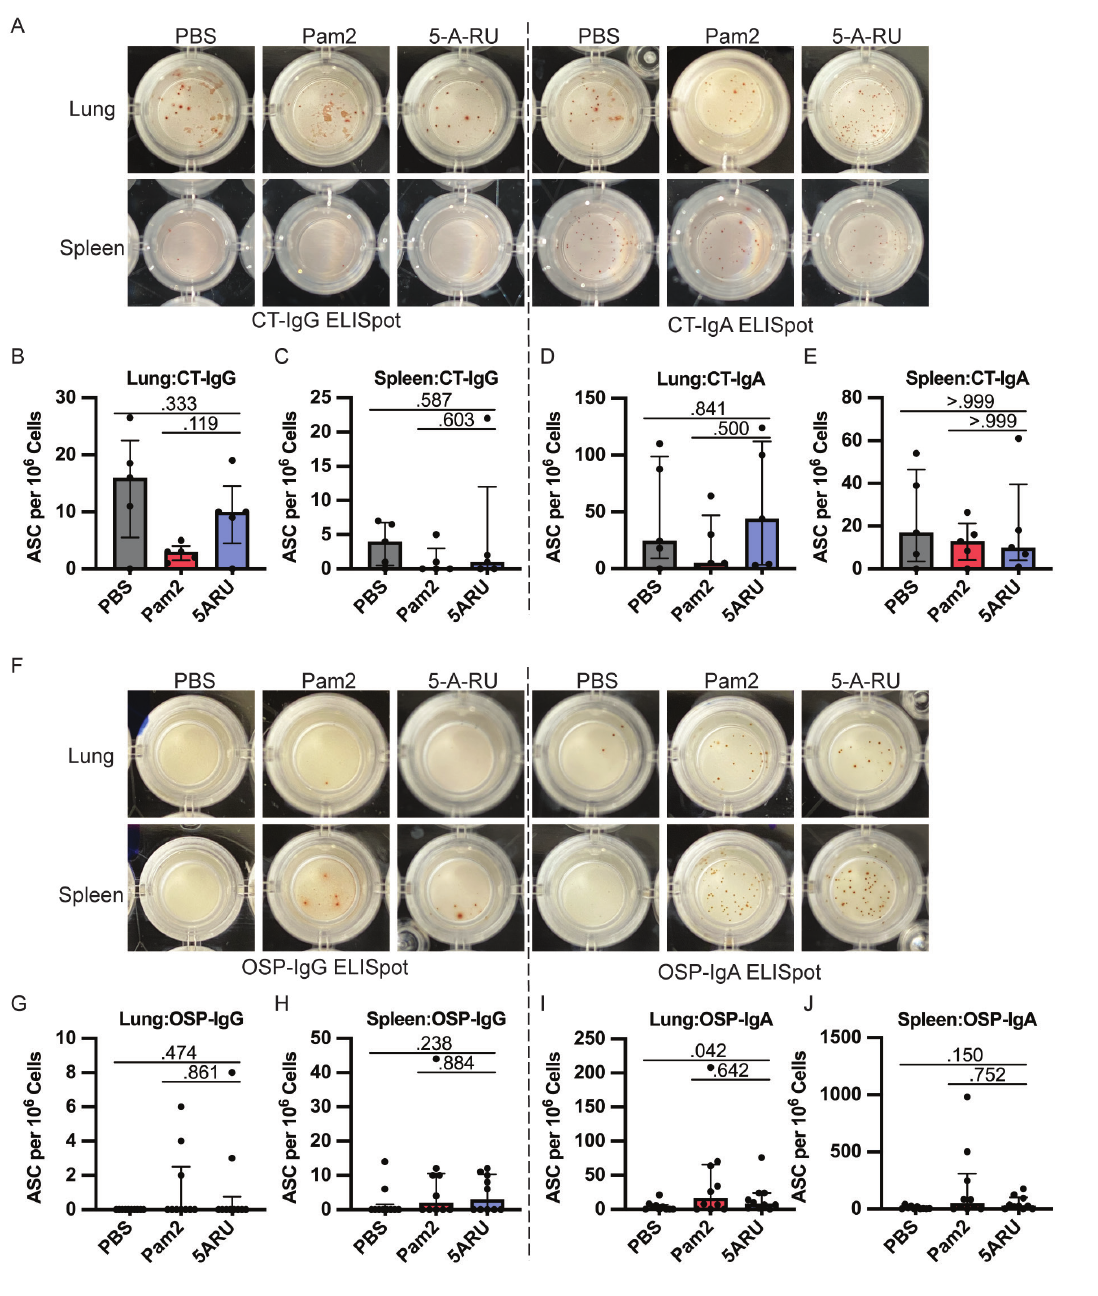
Figure 3. Intranasal 5-A-RU has no effect on protein or polysaccharide-specific antibody-secreting cell frequency in live V. cholerae vaccination. ( A ) Representative CT-IgG (left) and CT-IgA (right) ELISpot images from day 35 endpoint lung (top) and spleen (bottom) cells. ( B-E ) lung and spleen CT-IgG ( B- C ) and CT-IgA ( D-E ) ASC frequency per 10 6 live cells. Data are represented as Median with IQR from 1 independent experiment. n=5 mice per group. ( F ) Representative OSP-IgG (left) and OSP-IgA (right) ELISpot images from day 35 endpoint lung (top) and spleen (bottom) cells. ( G-J ) lung and spleen OSP-IgG ( G-H ) and OSP-IgA ( I-J ) ASC frequency per 10 6 live cells. Data are represented as Median with IQR from 2 independent experiments. n=10 mice per group. P values determined by 2-tailed Mann-Whitney U